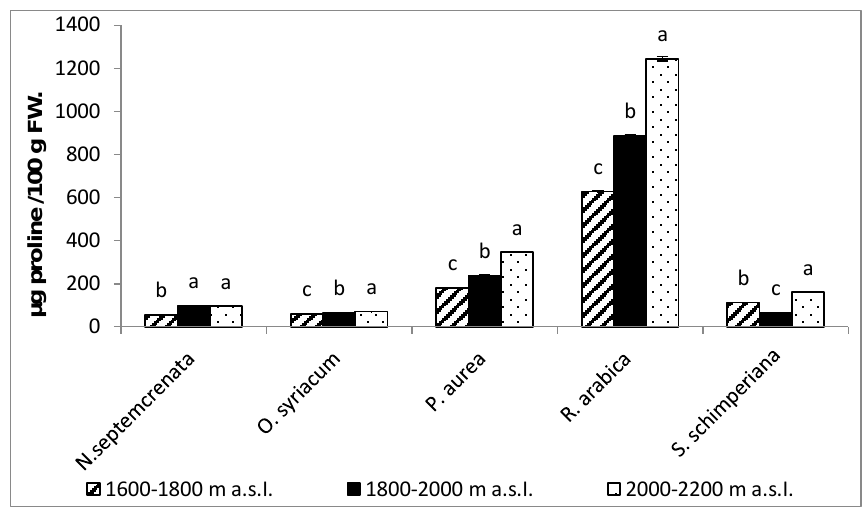
Figure 6. Change in proline contents for five plant species grown at di ff erent altitudes of SKP mountains. Each value is the mean of three replicates ± SE. Bars with di ff erent letters are significantly di ff erent at p ≤ 0.05.